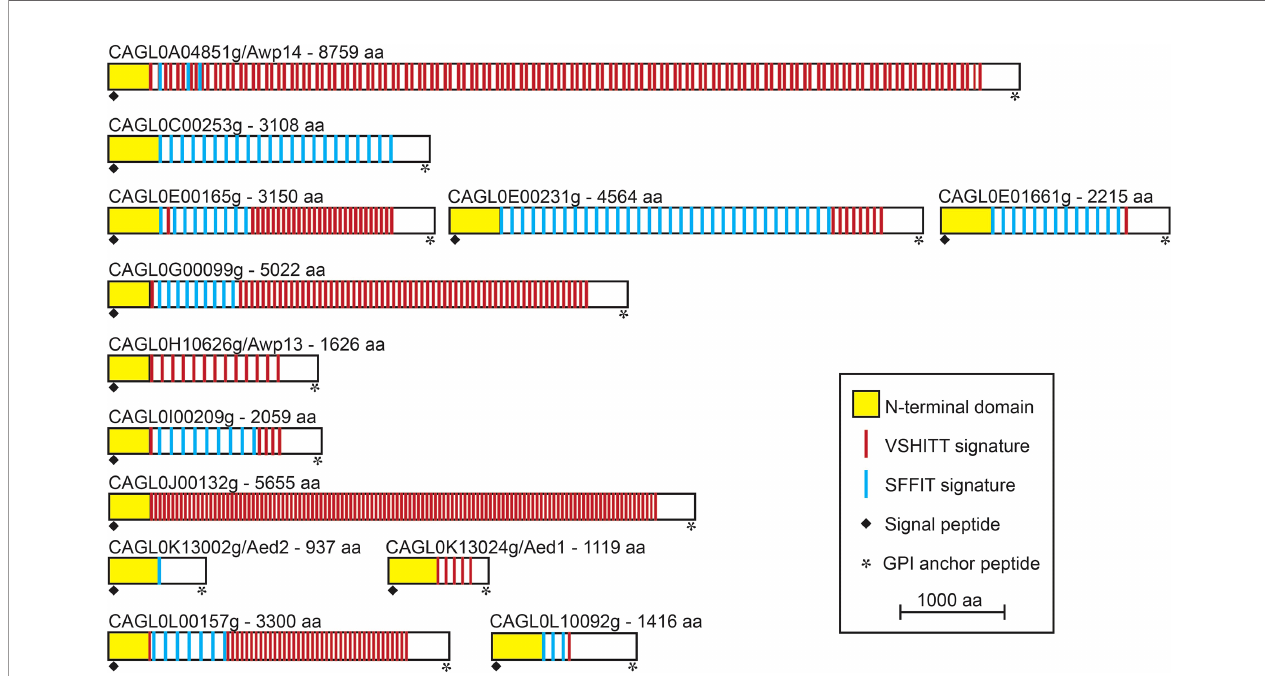
FIGURE 2 | Modular organization of the 13 GPI-modi fi ed cluster III cell wall adhesins in C. glabrata ATCC 2001. In all proteins, an N-terminal ligand-binding domain is followed by a C-terminal low complexity region containing megasatellites (large repeats) with VSHITT or SFFIT cores. Proteins are organized by their chromosomal localization and their sizes are to